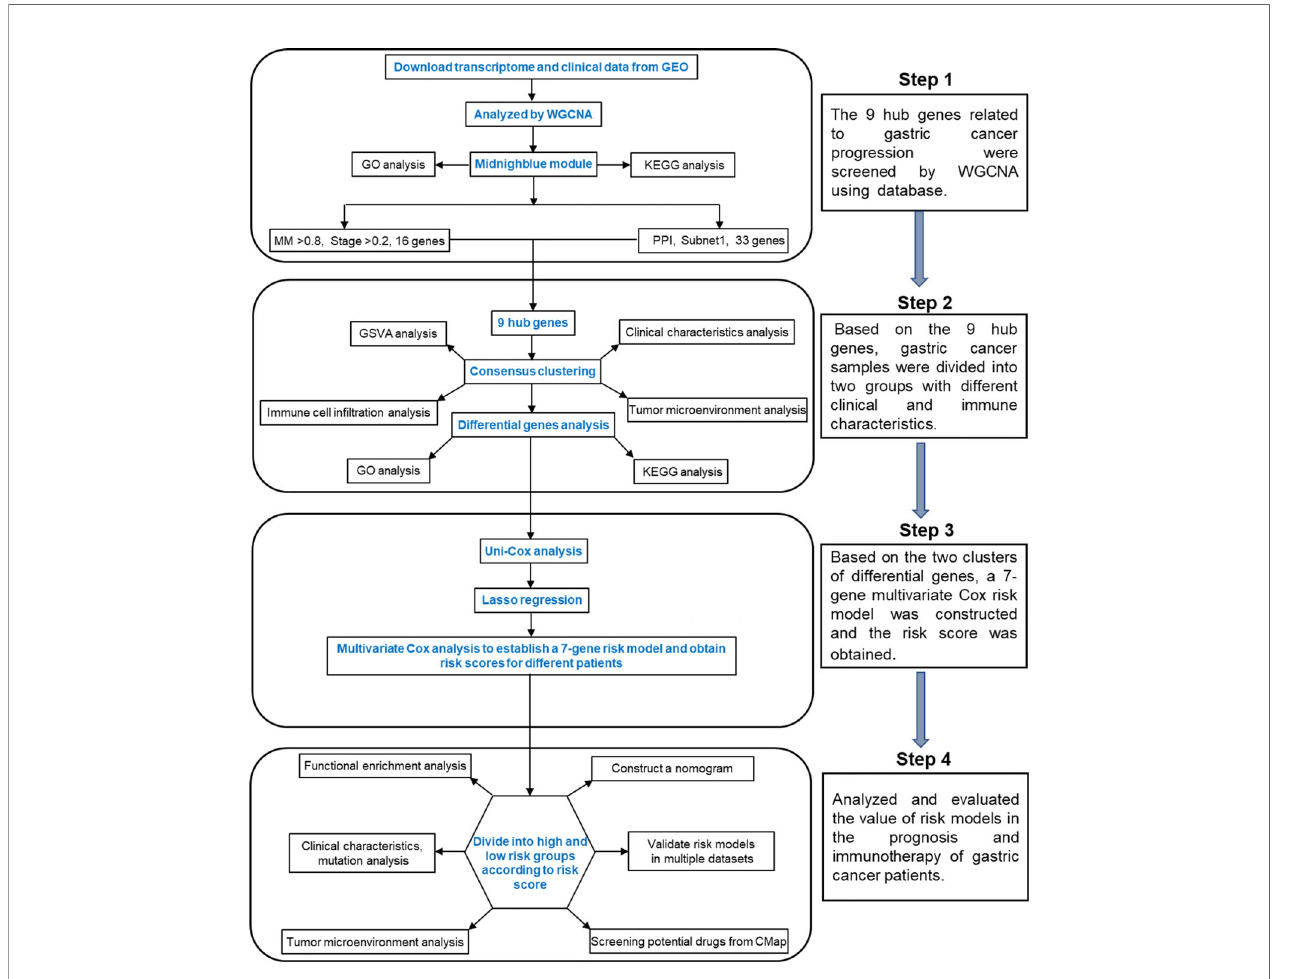
FIGURE 1 | Detailed fl ow chart of this